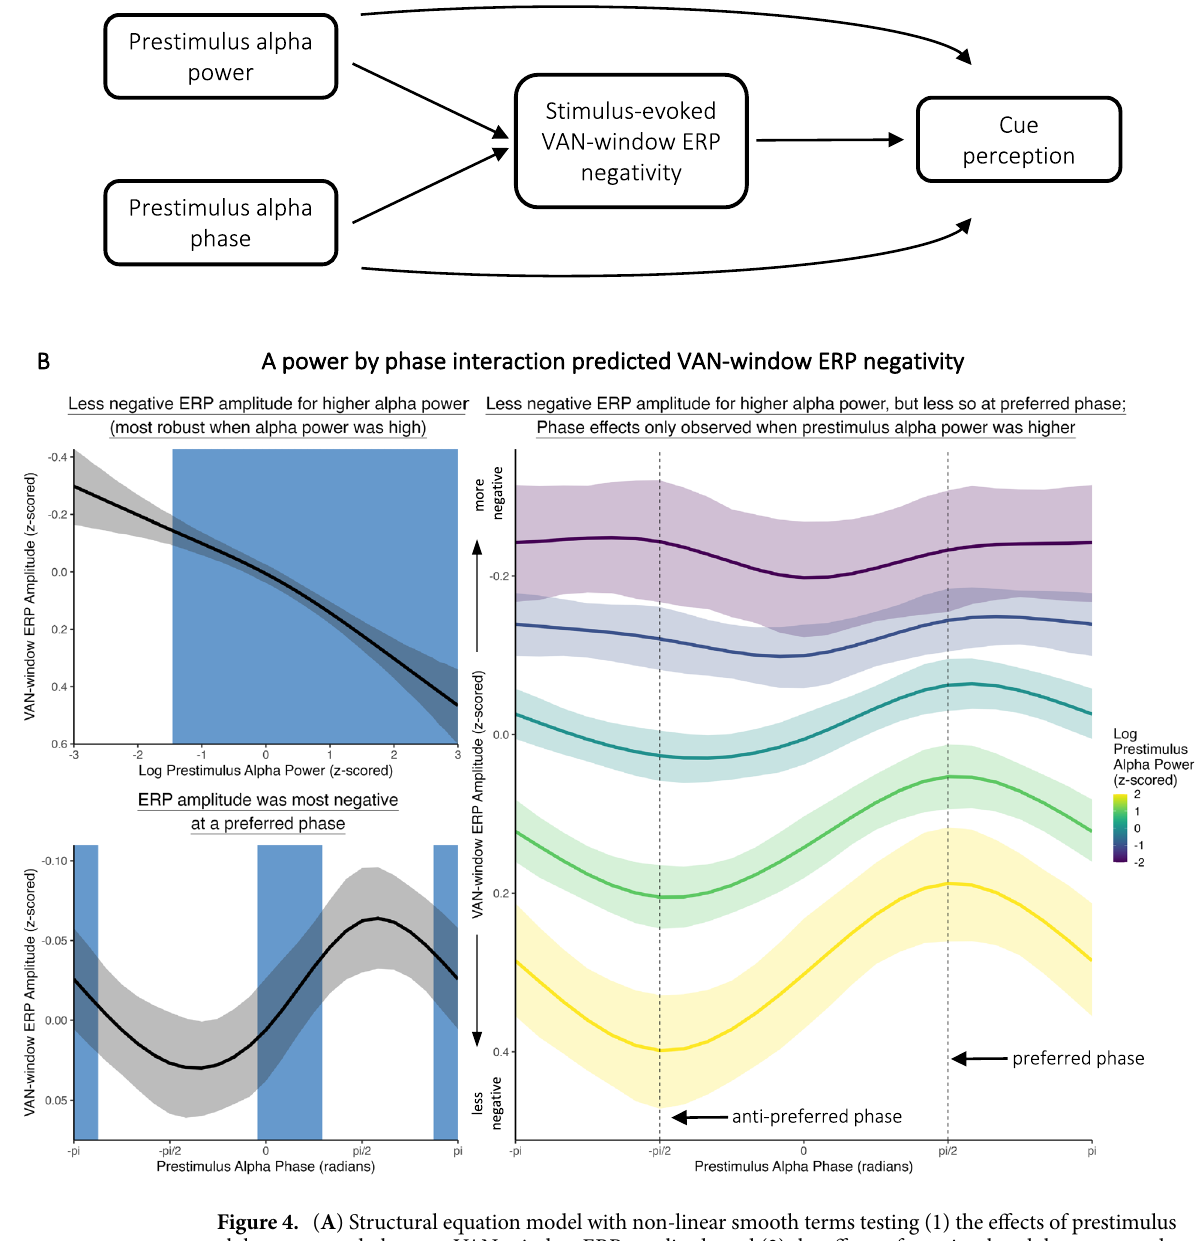
Figure 4. ( A ) Structural equation model with non-linear smooth terms testing (1) the effects of prestimulus alpha power and phase on VAN-window ERP amplitude and (2) the effects of prestimulus alpha power and phase and VAN-window ERP amplitude on cue perception. ( B ) The effects of prestimulus alpha power and phase on VAN-window ERP amplitude. The left panels show the simple effects of prestimulus alpha power (top) and phase (bottom). The blue shaded regions illustrate slopes where BF > 10. Prestimulus alpha power predicted VAN-window ERP amplitude, such that higher alpha power was associated with less negative VAN amplitudes (i.e., a smaller VAN). This effect was primarily observed when prestimulus alpha power was above the mean. Prestimulus alpha phase also predicted VAN-window ERP amplitude, such that more negative amplitudes were associated with a preferred phase, and less negative amplitudes were associated with an anti-preferred phase. These effects were characterized by an alpha power by alpha phase interaction, where the effects of phase were mostly observed when prestimulus alpha power was